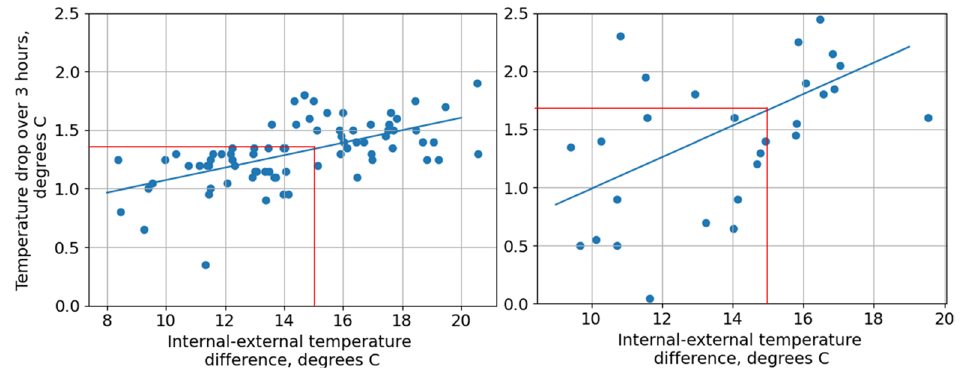
Figure 3. Temperature drop metric derived for two dwellings in the IDEAL dataset, one with low ( left ) and one with high ( right ) statistical error. Left : temperature drop 1.3 °C, statistical error 3%. Right : temperature drop 1.7 °C, statistical error 16%.